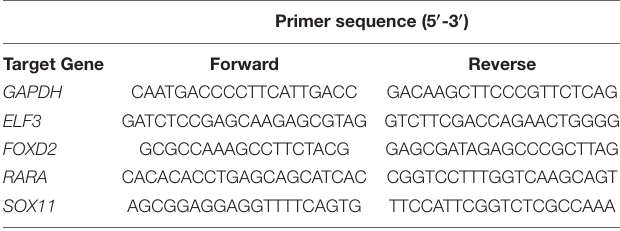
TABLE 1 | Primer sequences of the genes used for